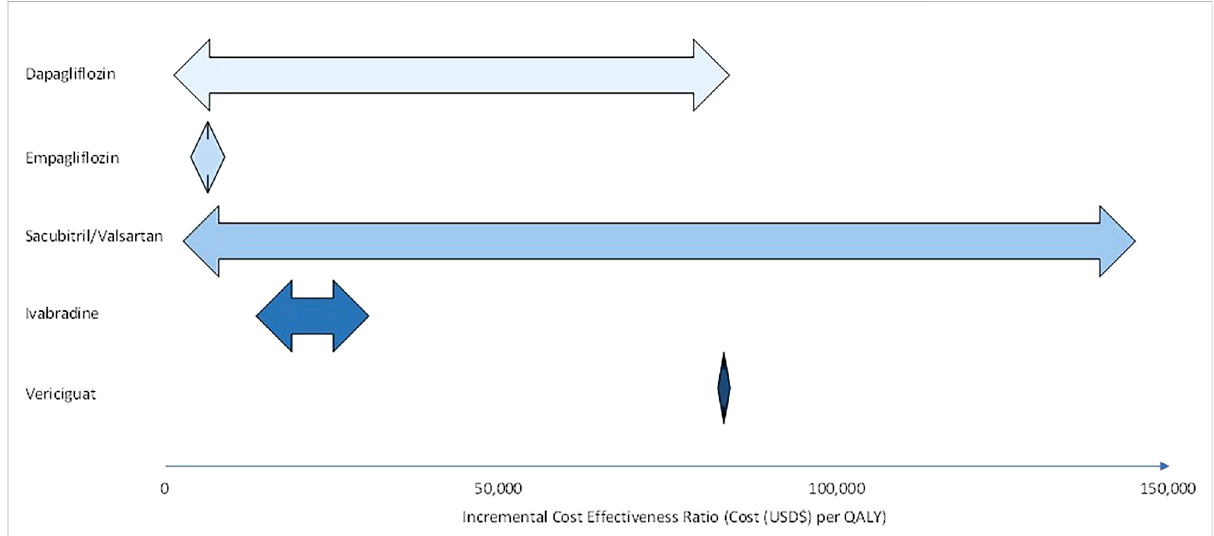
FIGURE 1 Range of incremental cost effectiveness ratios for dapagli fl ozin, empagli fl ozin, sacubitril/valsartan, ivabradine, and vericiguat in heart failure (HFrEF and HFpEF)